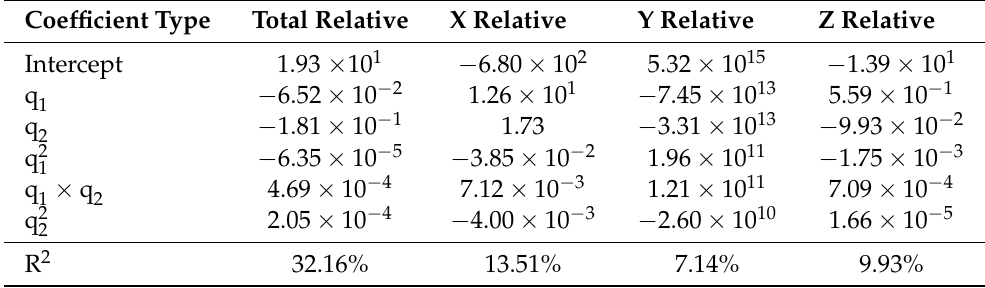
Figure 20. Overall loading residuals as a function of the overall loads applied. The discrete levels of loading are highlighted as orange-yellow vertical lines. The dashed grey line indicates zero error and that actual overall mass matches what is predicted by calibration. Meanwhile, the red diagonal line indicates the line of best fit. Table 8. Coefficients and R-squared metrics of mixed-quadratic surface fits for each relative resid- ual